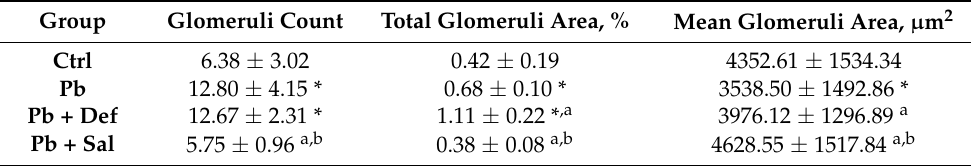
Table 1. Glomeruli count in selected region of interest (ROI), glomeruli area as a percent of the total kidney area and mean glomeruli area ( µ m 2